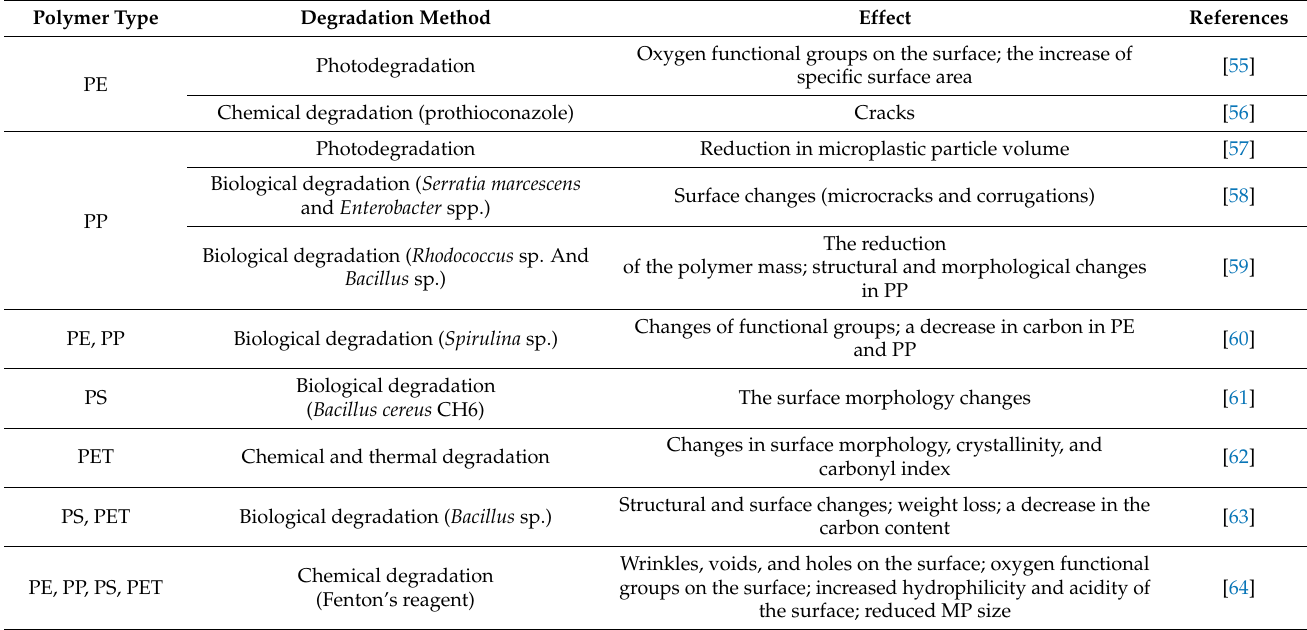
Table 1. Microplastics degradation effects.